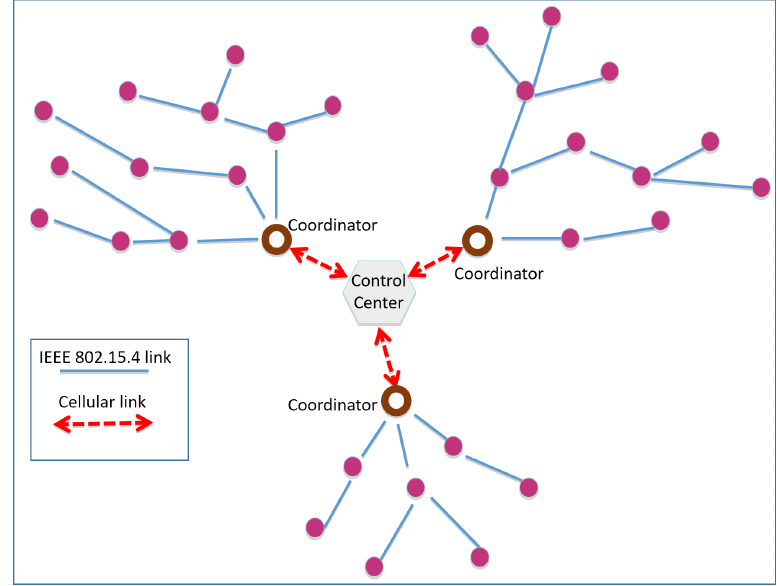
Figure 3. Montechiarugolo: exemplification of the network